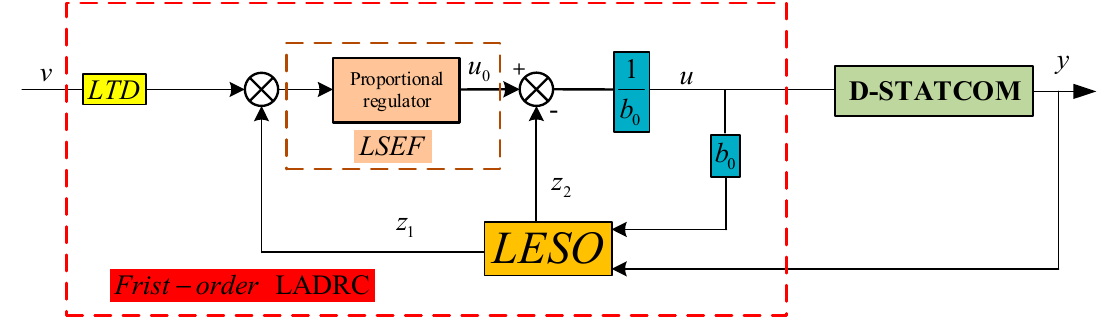
Figure 2. LADRC structure diagram.